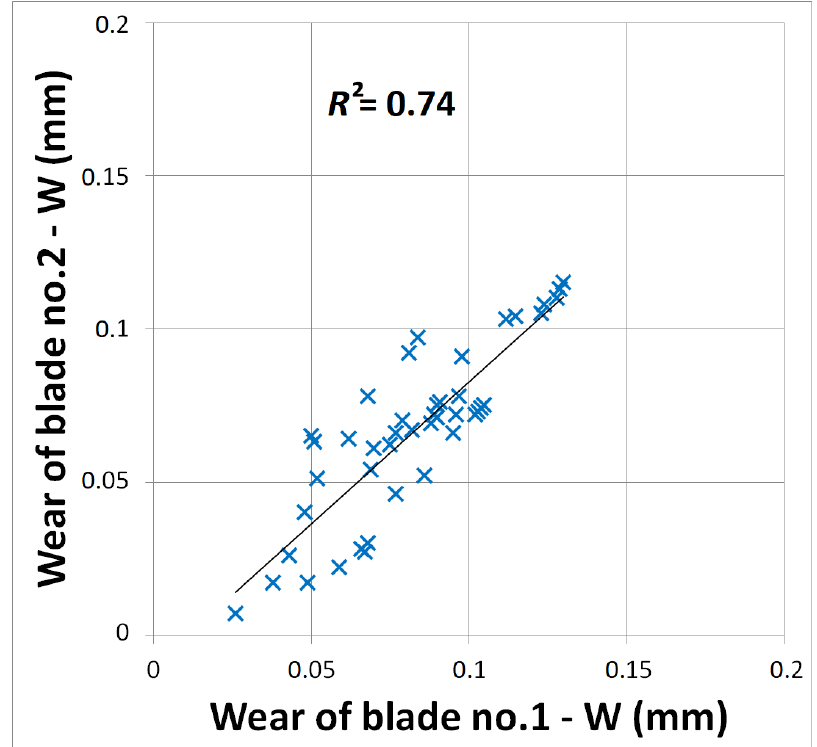
Figure 13. The correlation between the wear of two blades used in the same drill for tools belonging to Group B (experimental group containing four two-blade tools that were coated with “TiN/AlTiN”).